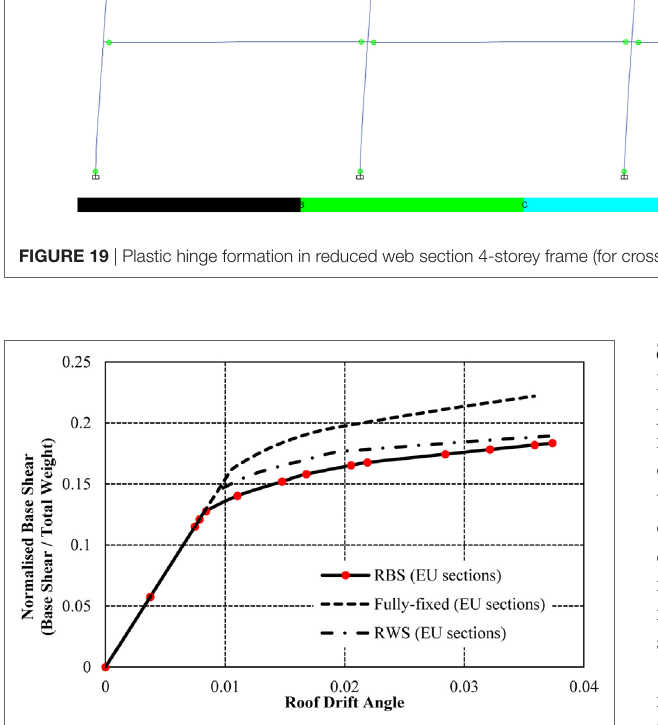
Figure 20 | Normalized capacity curve for 8-storey frame with fully fixed connections, reduced web sections (RWSs), and reduced beam sections (RBSs).